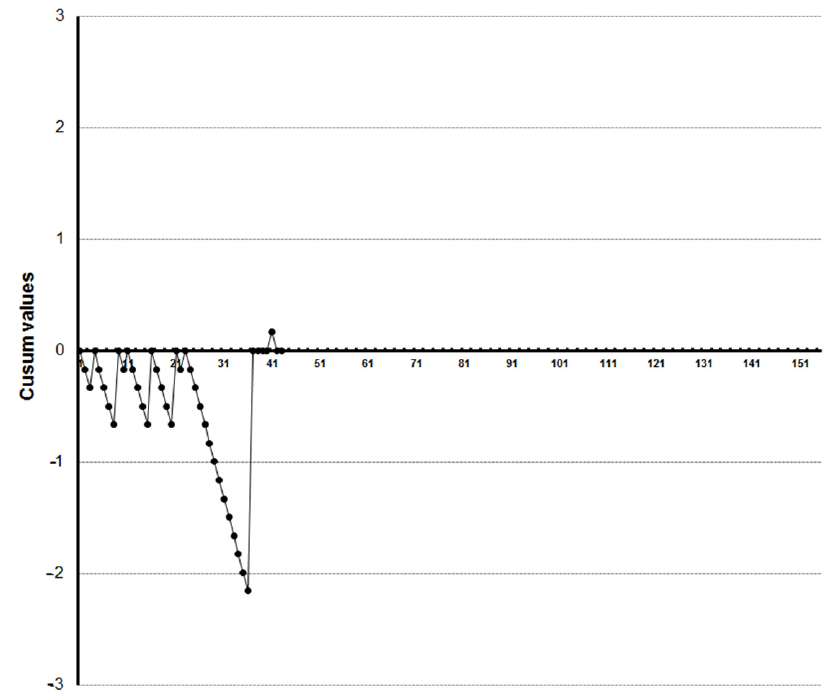
Figure 5. LC-CUSUM curve for trainee one.